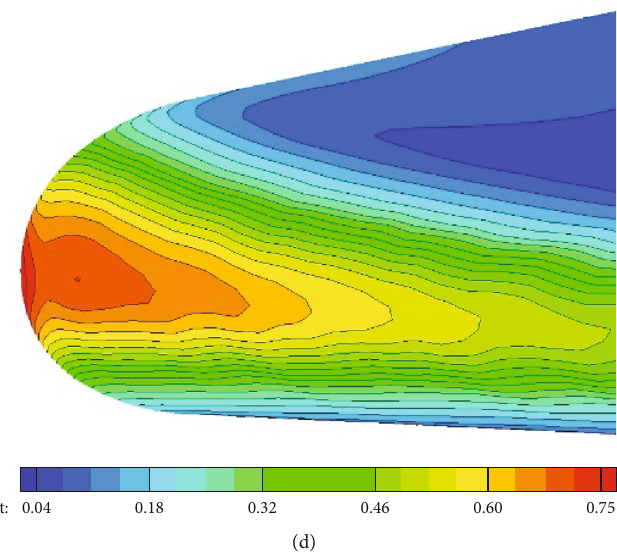
Figure 14: Contour of St around the head of blunted waveriders: (a) WR1-G 0 ; (b) WR1-G 2 ; (c) WR2-G 0 ; (d) WR2-G 2 .